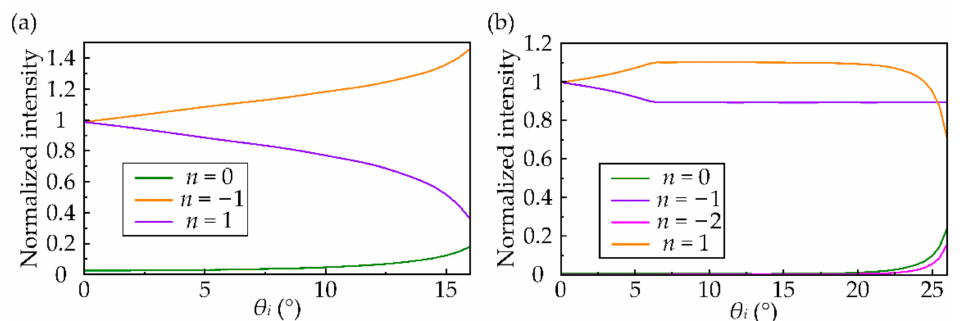
Figure 7. Simulated results of the normalized intensity of the reflected waves at different incident angles ( a ) in the case of a = 1.4 λ 0 and ( b ) in the case of a = 1.8 λ 0 . All the intensities are normalized to the intensity of the split beam 1 at normal